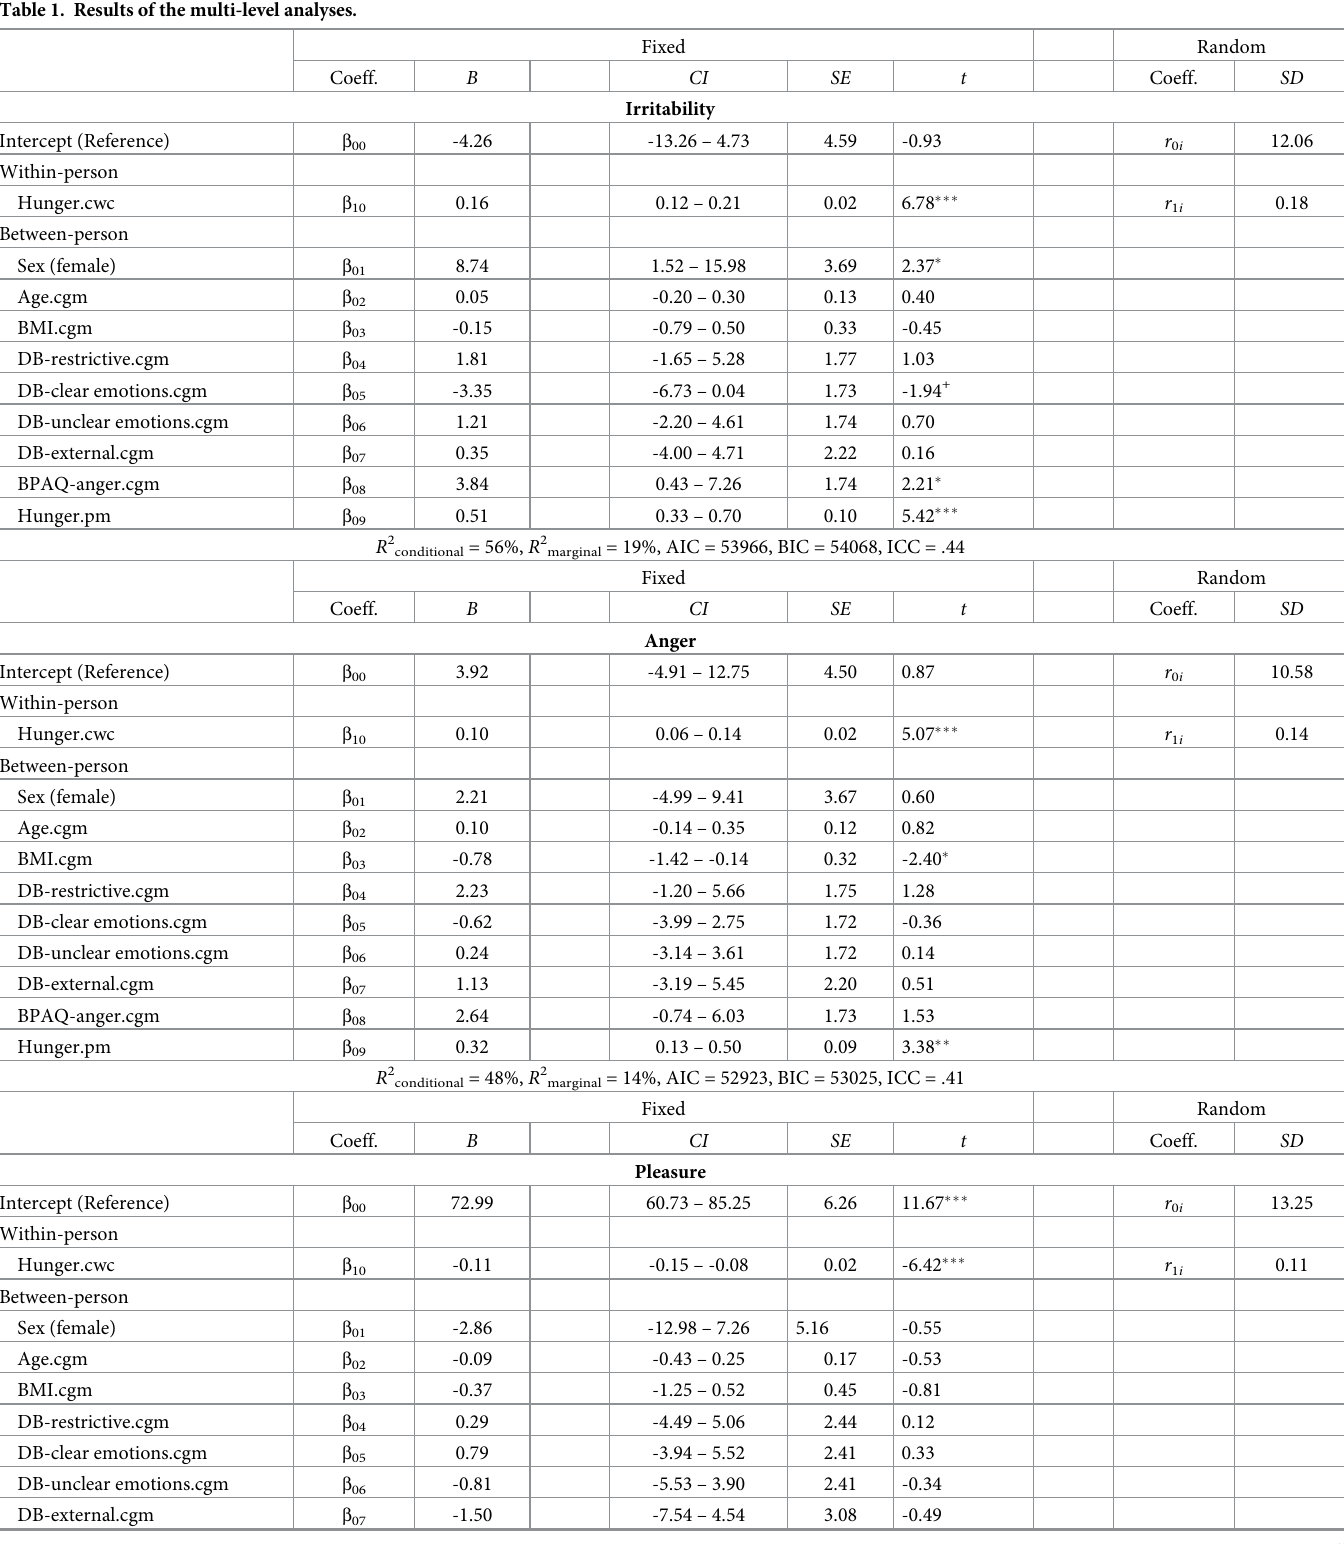
Table 1. Results of the multi-level analyses. Fixed Random Coeff. B CI SE t Coeff. SD